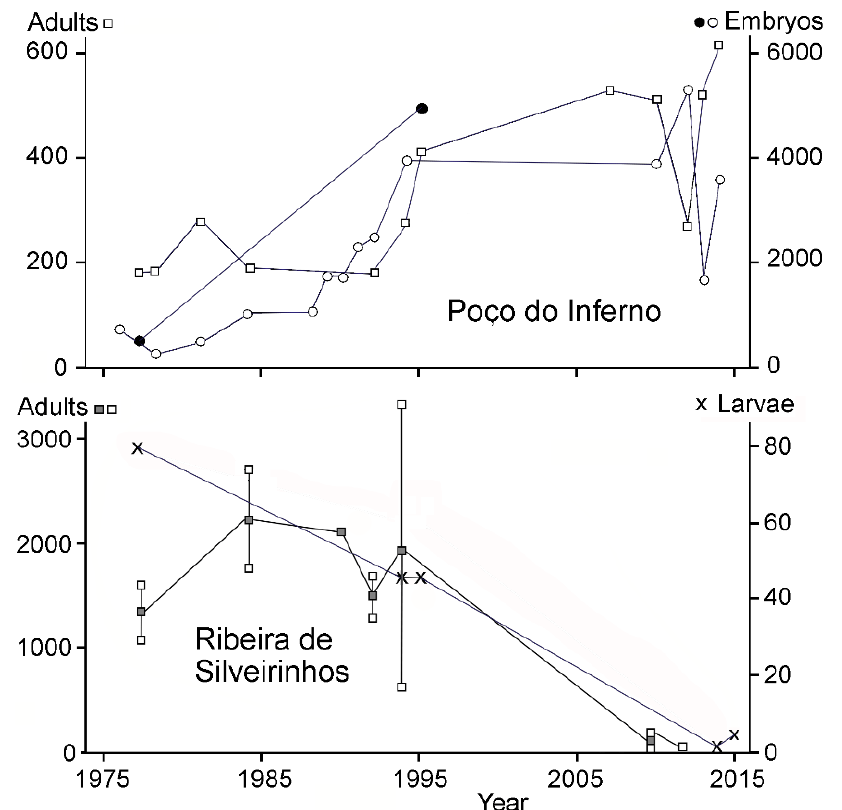
Figure 2. Numbers of Chioglossa lusitanica observed and population sizes estimated in the Serra de Santa Justa in northwestern Portugal over the 1976–2015 period. ( Top panel ) Embryo (round symbols) and adult numbers (squares) counted in two mine galleries at Poco do Inferno. The 1977 and 1995 cumulative embryo counts are shown separately with solid round symbols. ( Bottom panel ) First-year larvae counted in the Ribeira de Silveirinhos (crosses) and adult population size estimates from capture–mark–recapture in the “dam” (squares, Ň b solid symbols, Ň b ± SE open symbols). For numerical detail see Appendix